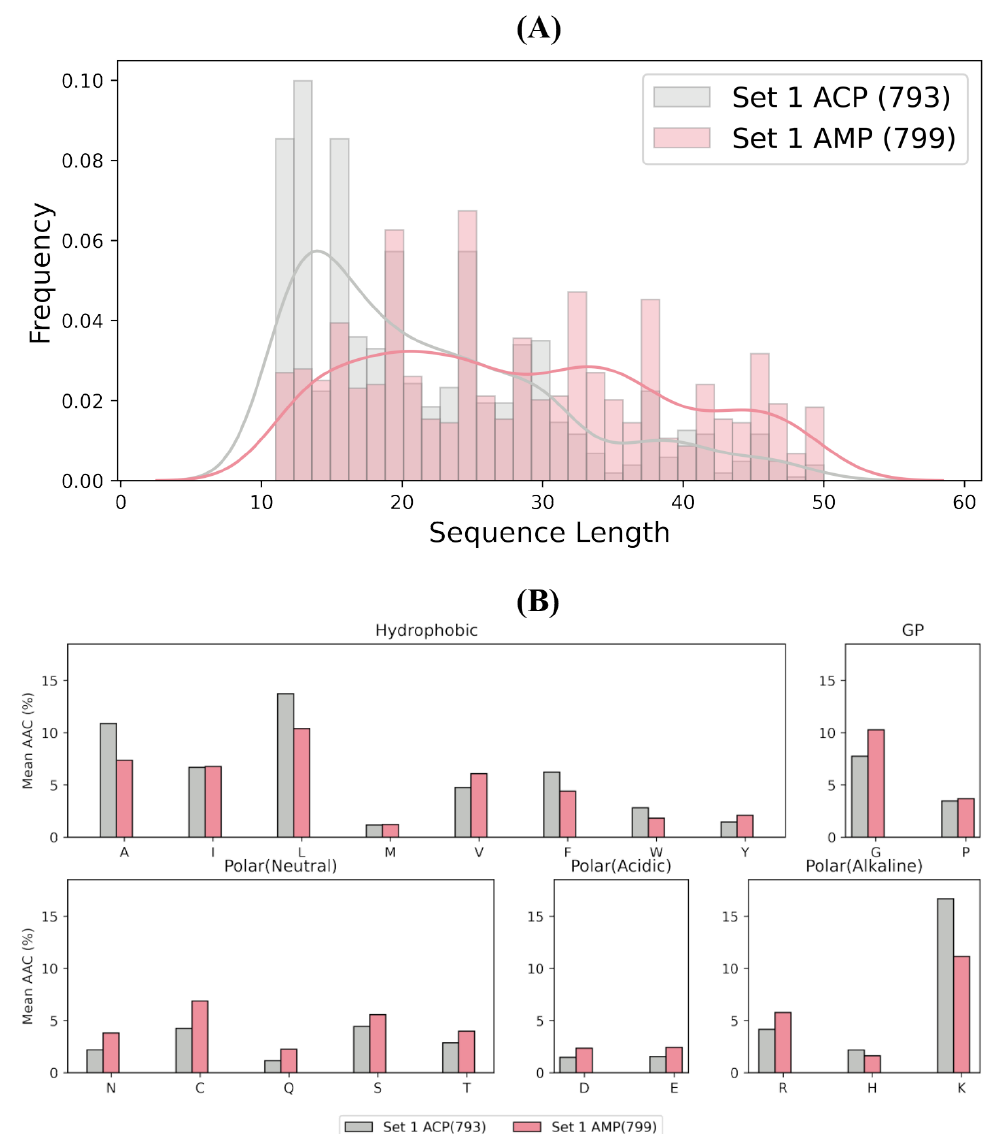
Figure 4. Statistics for Set 1. ( A ) The distribution of amino acid sequence length among positives (ACPs) and negatives (AMPs). ( B ) Mean AAC of positives (ACPs) and negatives (AMPs). The amino acids are grouped according to their physiochemical